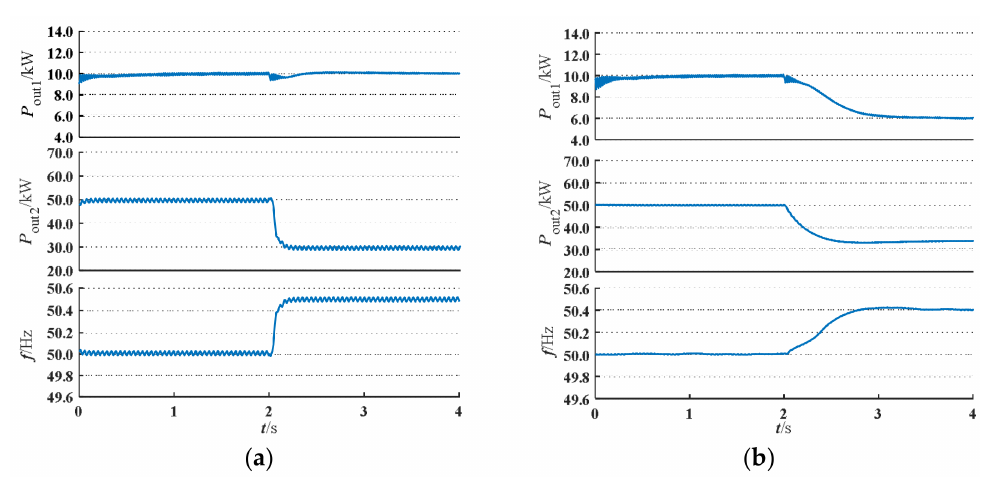
Figure 18. ( a ) Frequency regulation results of traditional PV storage system in generator mode; ( b ) Frequency regulation results of PV storage virtual synchronous generator system in the generator mode.